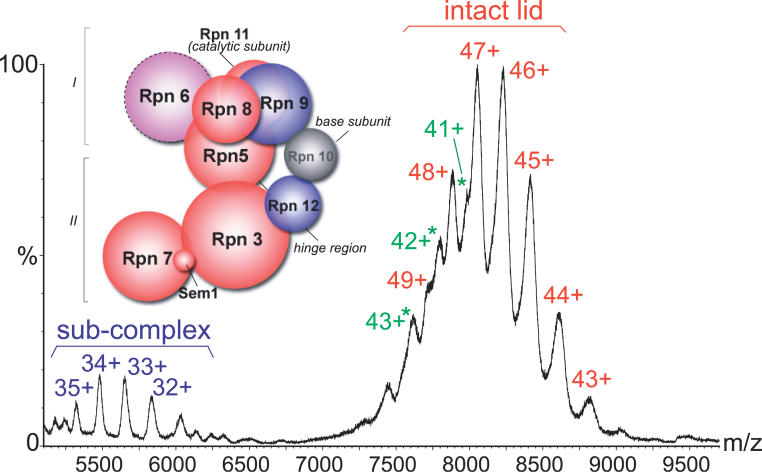
Mass spectrum of the 19S lid complex isolated from yeast cells. The spectrum shows a series of peaks, labeled with charge states in red, corresponding to the nine protein components of the lid.